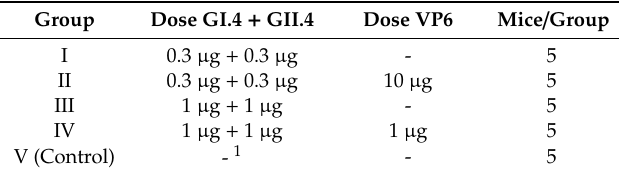
Table 1. Experimental and control groups of immunized mice. Mice were immunized intradermally (ID) at day 0 and 21 with the indicated dose at a volume of 50 µ L / injection and terminated at day 35. Group Dose GI.4 + GII.4 Dose